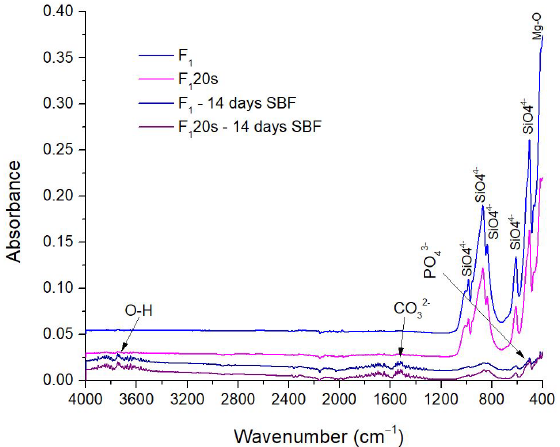
Figure 13. FTIR Spectra of F 1 , F 1 20s before and after 14 days in SBF.